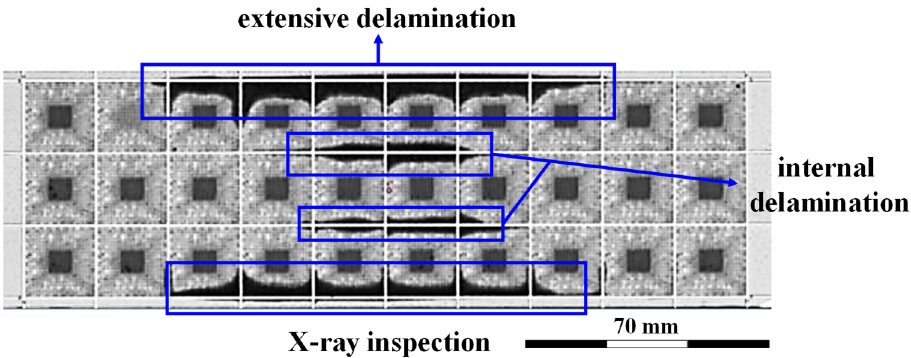
Figure 1. Illustration of delamination in LFBGA packaging process.